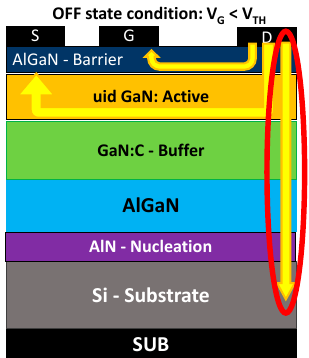
Figure 1. Schematic representation of GaN high-electron-mobility transistors (HEMTs), showing vertical leakage current between drain and substrate in the OFF-state condition.